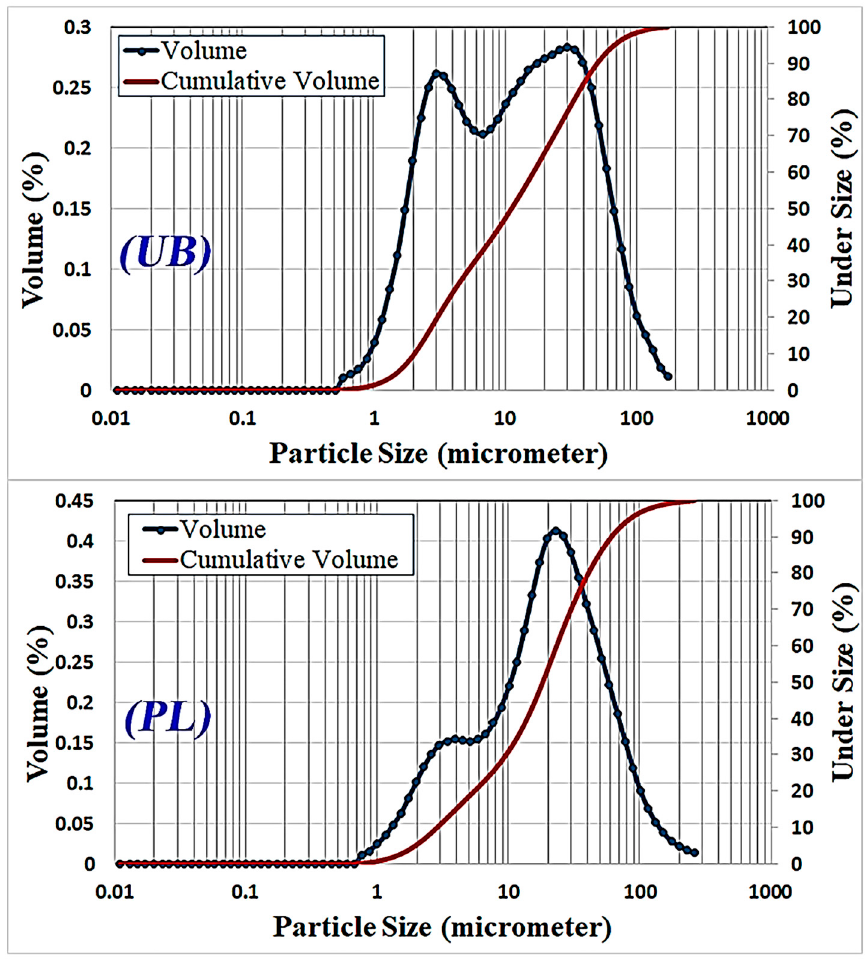
Figure 1. Particle size distribution for the magnetic fraction of UB and PL fly ashes.